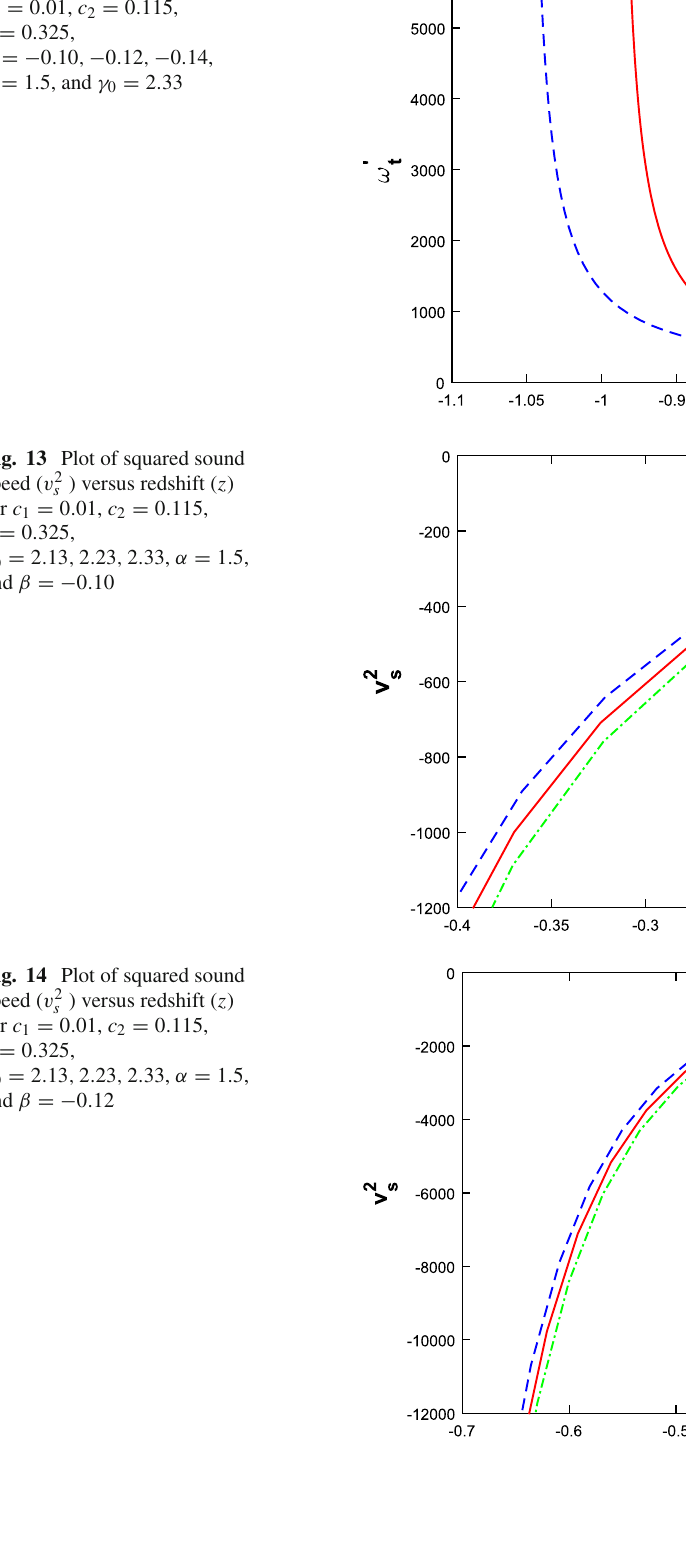
Fig. 12 Plot of energy density of THDE versus redshift ( z ) for c 1 = 0 . 01, c 2 = 0 . 115, k = 0 . 325, β = − 0 . 10 , − 0 . 12 , − 0 . 14, α = 1 . 5, and γ = 2 . 33 0